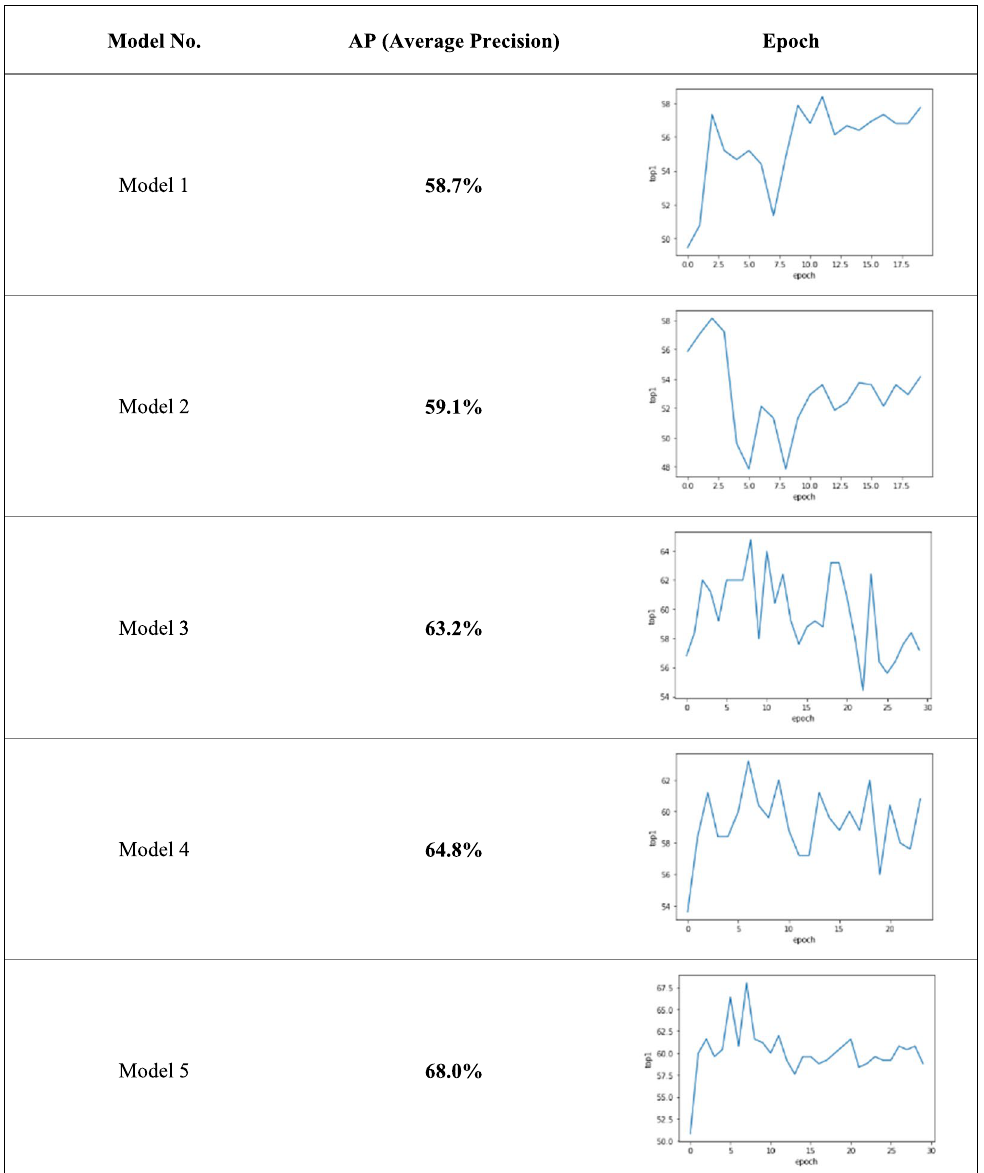
Table 2 Average precision of 5 roadway condition assessment